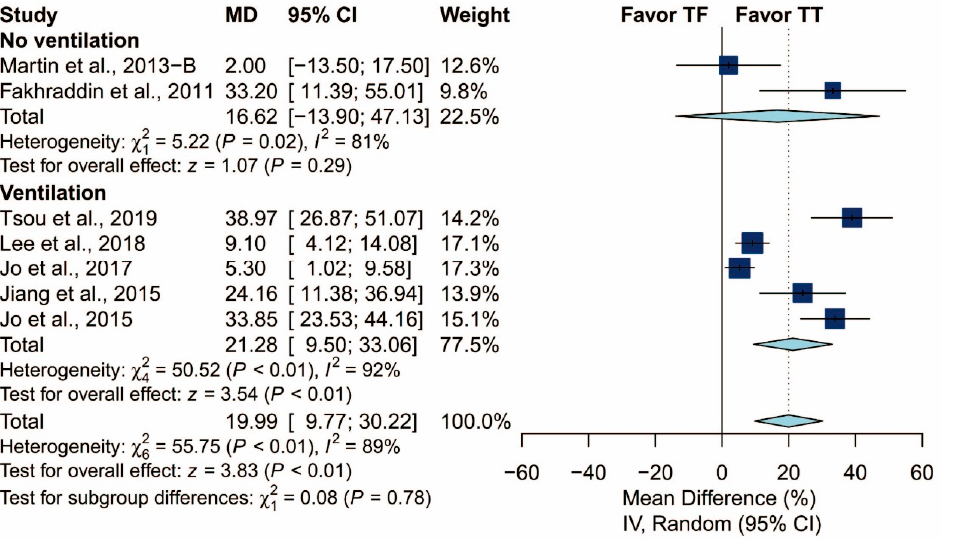
Figure 12. Subgroup analysis of the proportion of adequate compression depth grouped by ventilation protocol (yes/no).